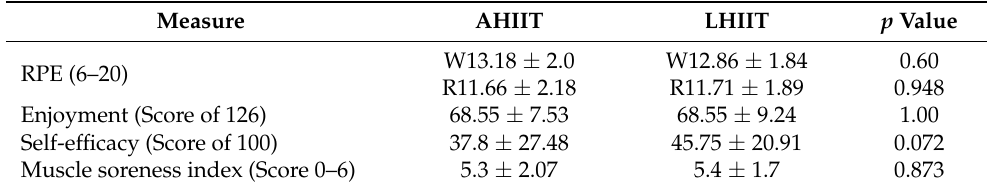
Table 5. Perception outcomes for AHIIT and LHIIT (mean ±